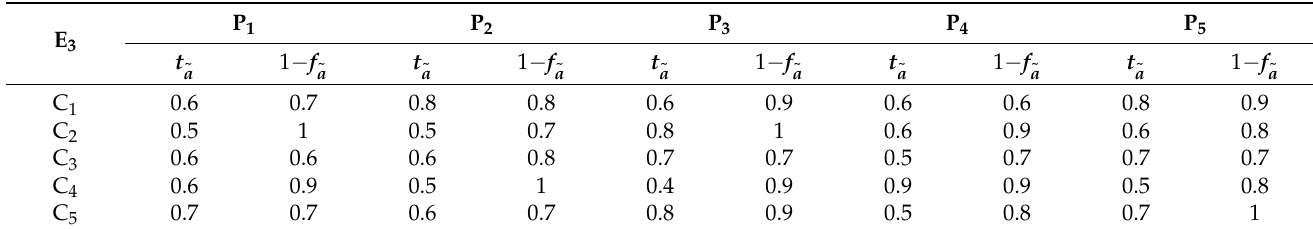
Table 16. Expert 3’s assessments on the different patients’ status.